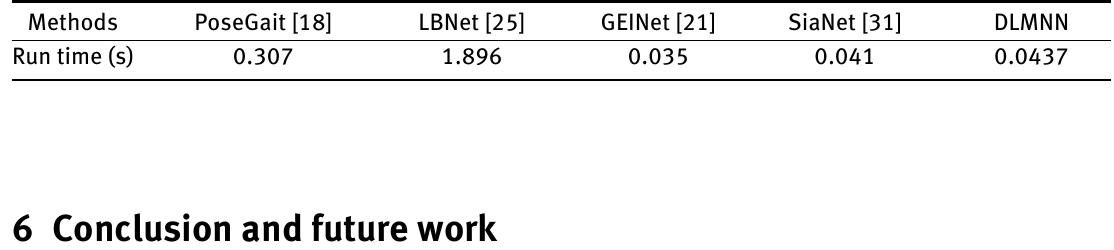
Table 6: The computational cost of different methods.